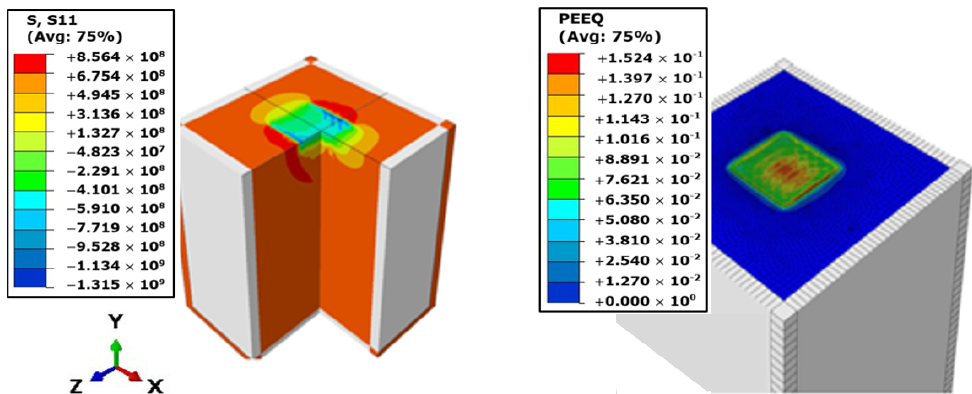
Figure 8. 3D simulation visualization of the stress (S11) and equivalent plastic strain (PEEQ) distribu- tion results of the peened